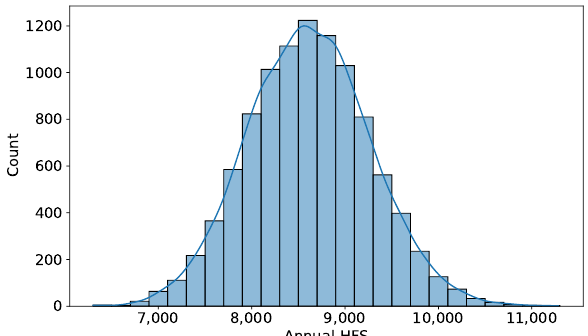
Figure 8. Annual HFS Histogram.